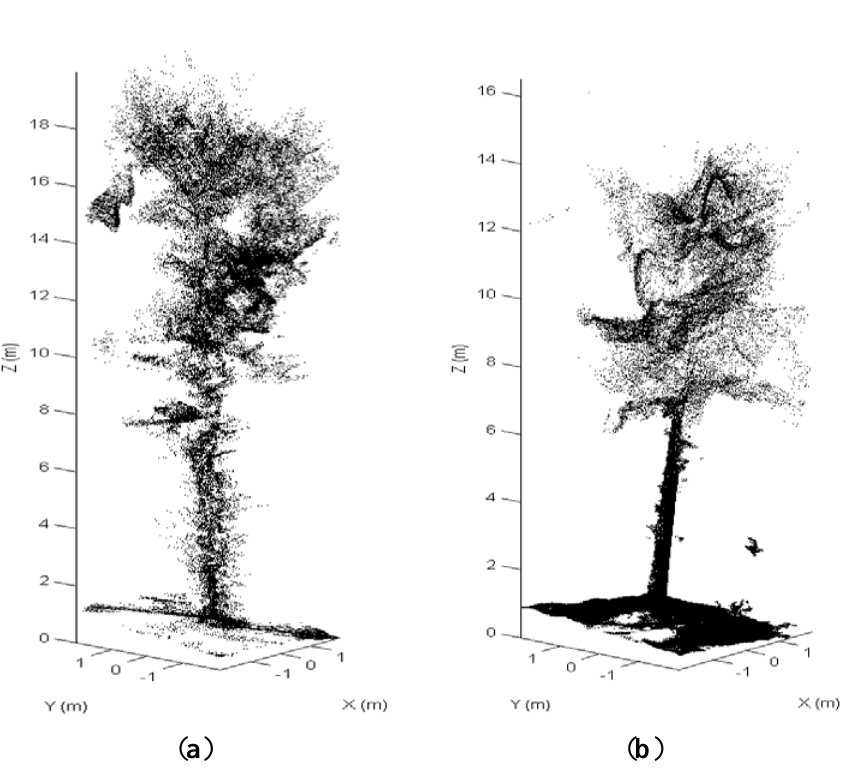
Figure 5. Two trees of similar sizes in dataset I. ( a ) Tree A is located near the plot center, far from the photographing path. ( b ) Tree B is located near a plot corner, close to the photographing